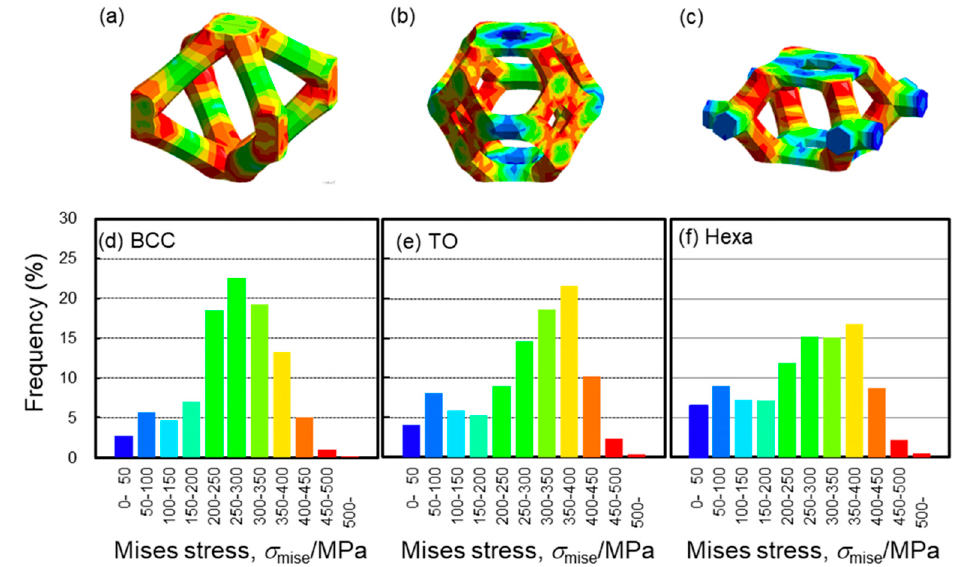
Figure 13. ( a – c ) Contour maps and ( d – f ) histograms showing the Mises stress distributions in BCC, TO and Hexa models obtained by of FEM analysis. The colors for bars in the histograms correspond to the those of the contour maps.